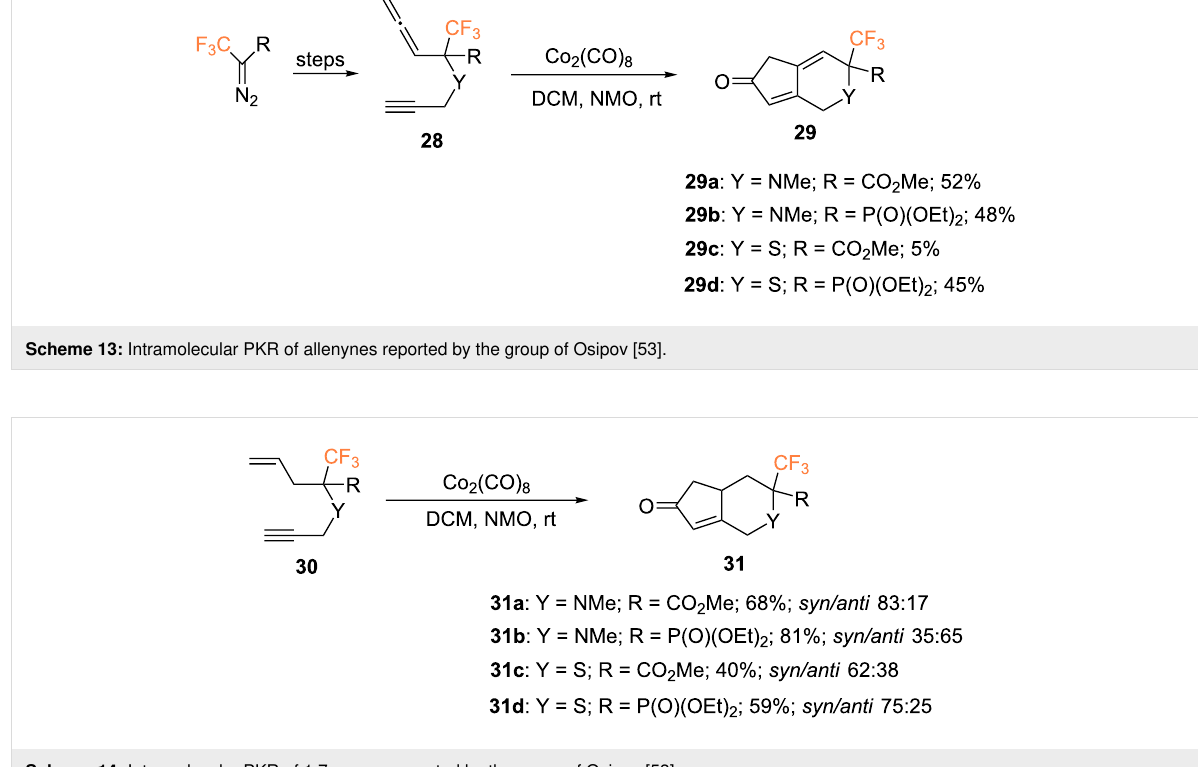
Scheme 14: Intramolecular PKR of 1,7-enynes reported by the group of Osipov